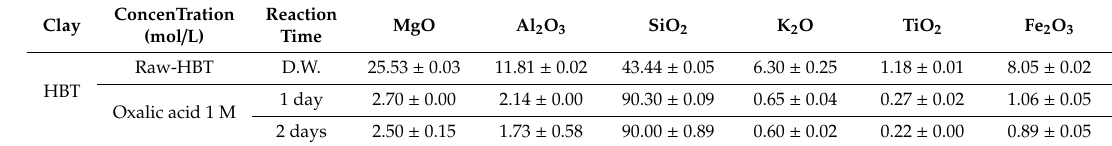
Table 1. Quantification using elemental information from the X-ray fluorescence (XRF) analysis (%). Clay